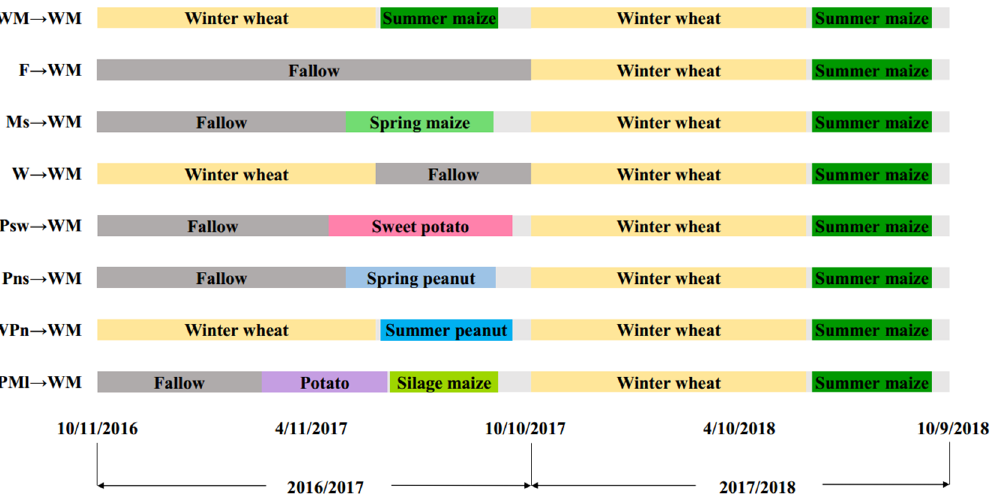
Figure 1. The timeline of the control (WM → WM, winter wheat–summer maize → winter wheat–summer maize) and seven diversified crop rotations in two years of this study.